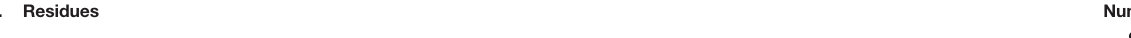
TABLE 1 | List of the promising conformational B-cell